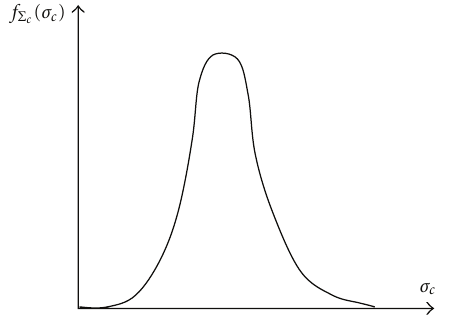
Figure 2: Density function f Σ characterising the statistical scatter in strength of the aneurysm